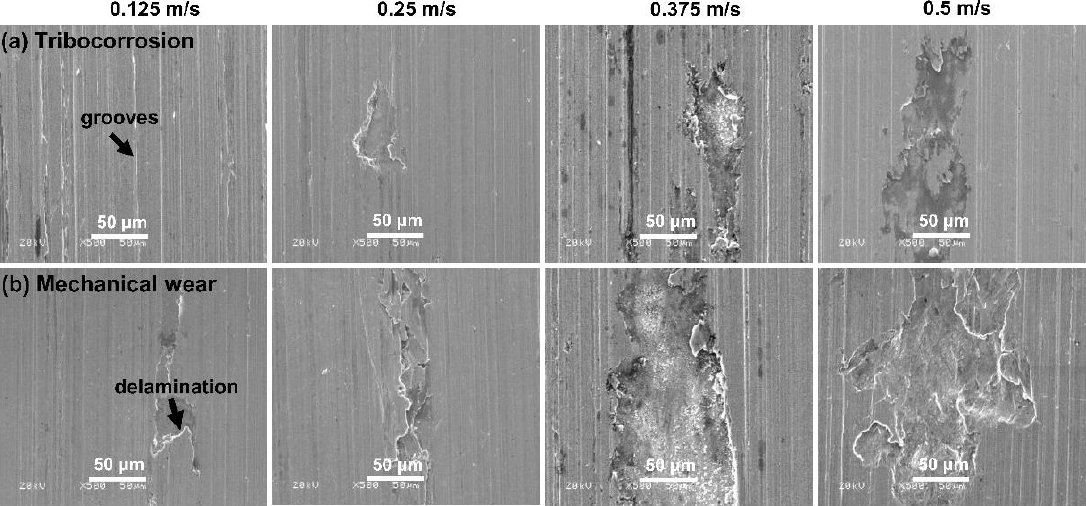
Figure 5. Damaged surface of Monel 400 alloy in conditions of ( a ) tribo-corrosion and ( b ) mechanical wear under different rotational velocities of 0.125 m/s, 0.25 m/s, 0.375 m/s and 0.5 m/s in seawater.